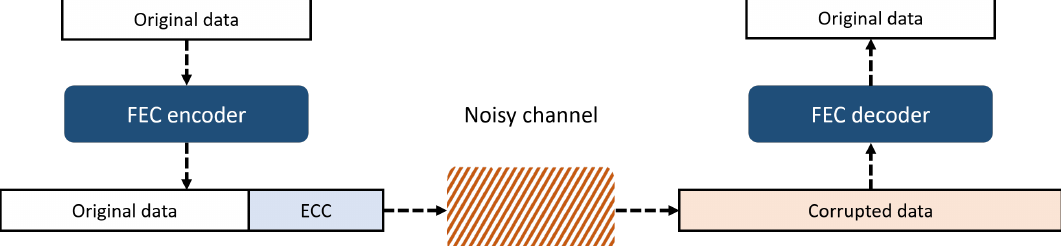
Figure 3. Schematic of forward error correction (FEC).